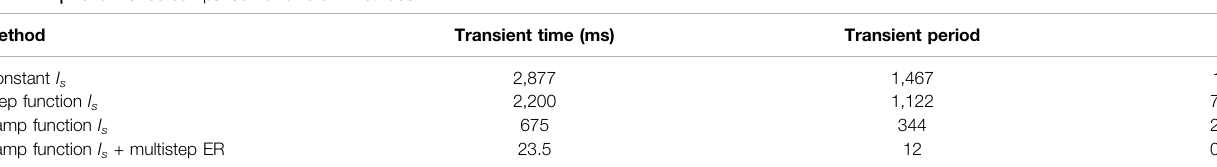
TABLE 2 | Performance comparison of different